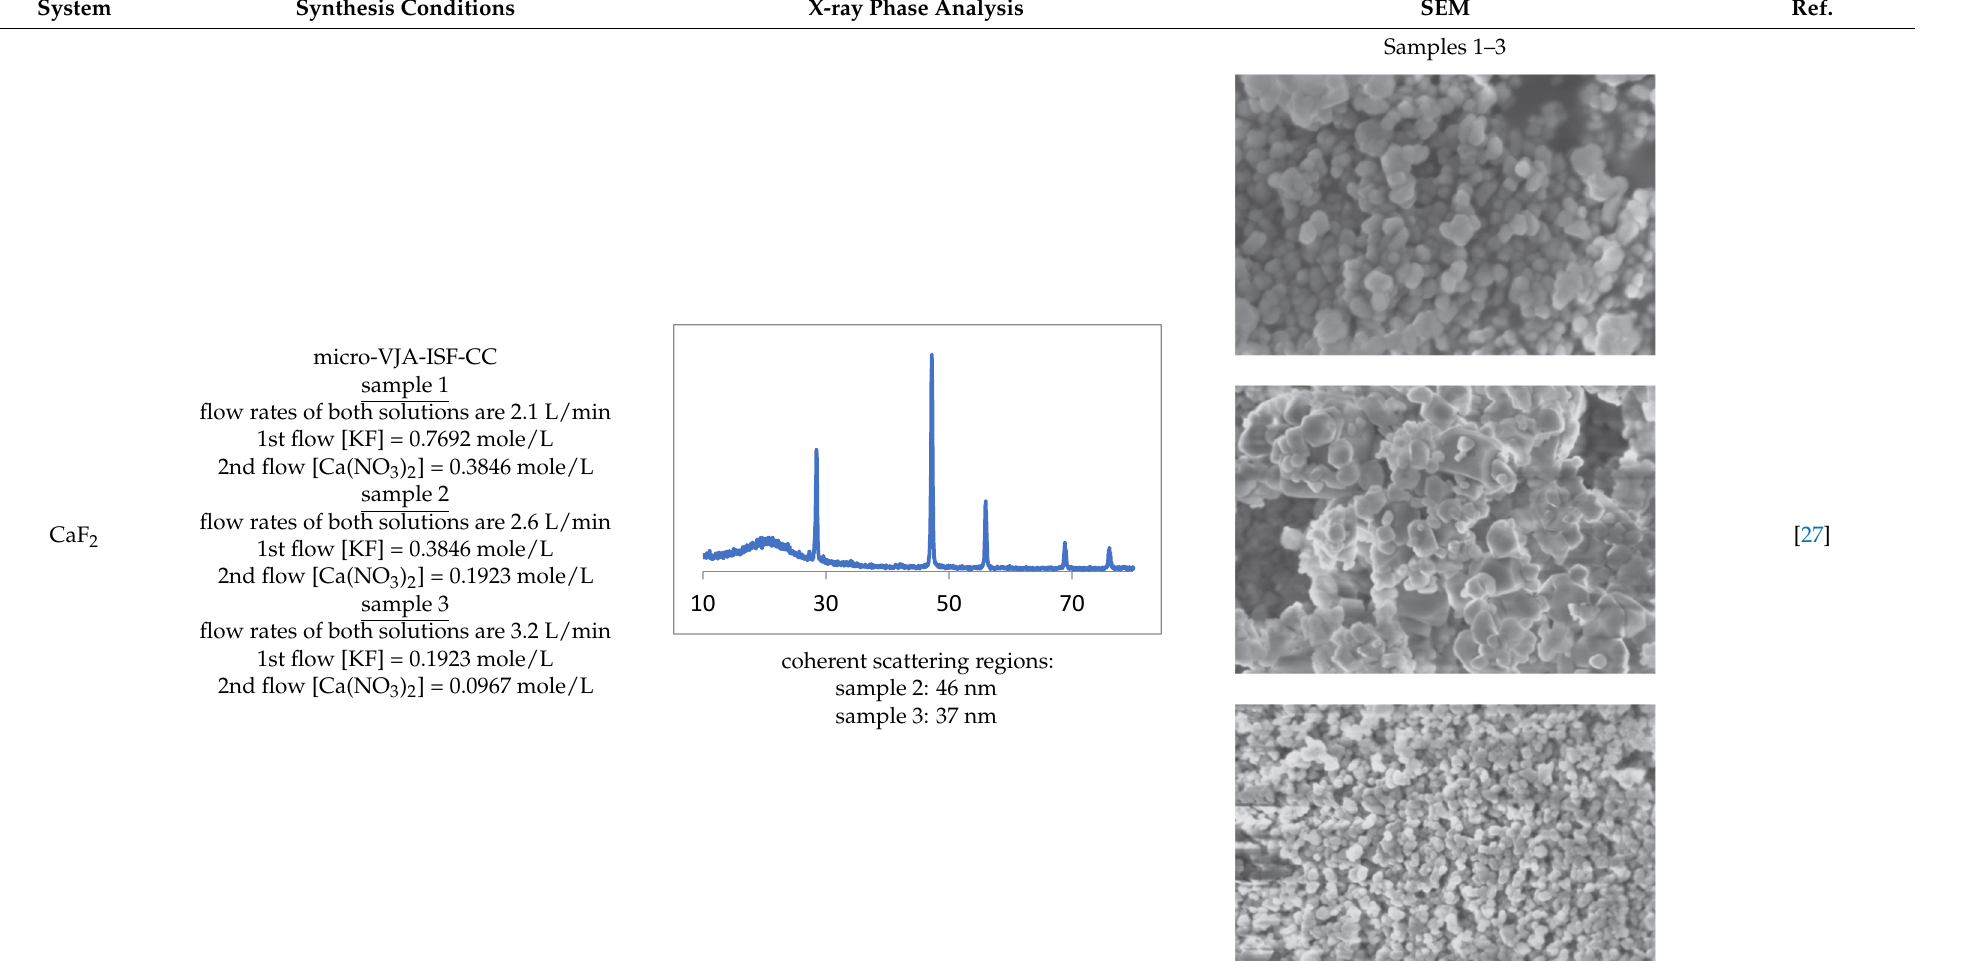
Table 3. Summary of synthesis results in various types of Microreactors with impinging swirled flows ( micro-VJA-ISF-CC ).